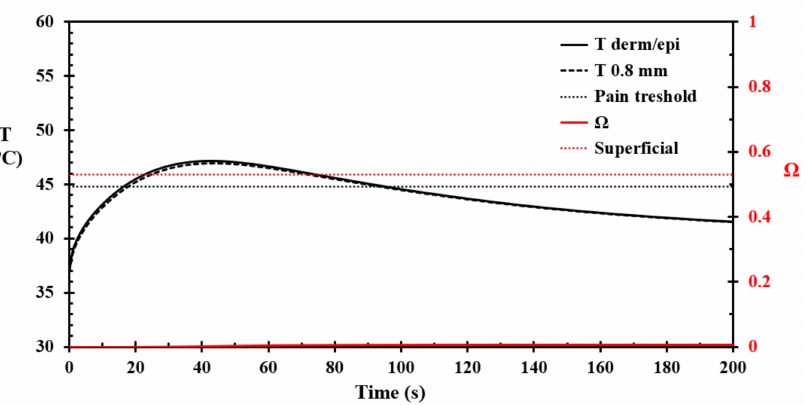
Figure 6. The basal layer and 0.8 mm depth skin temperature, and the corresponding damage integral development, versus time for Case